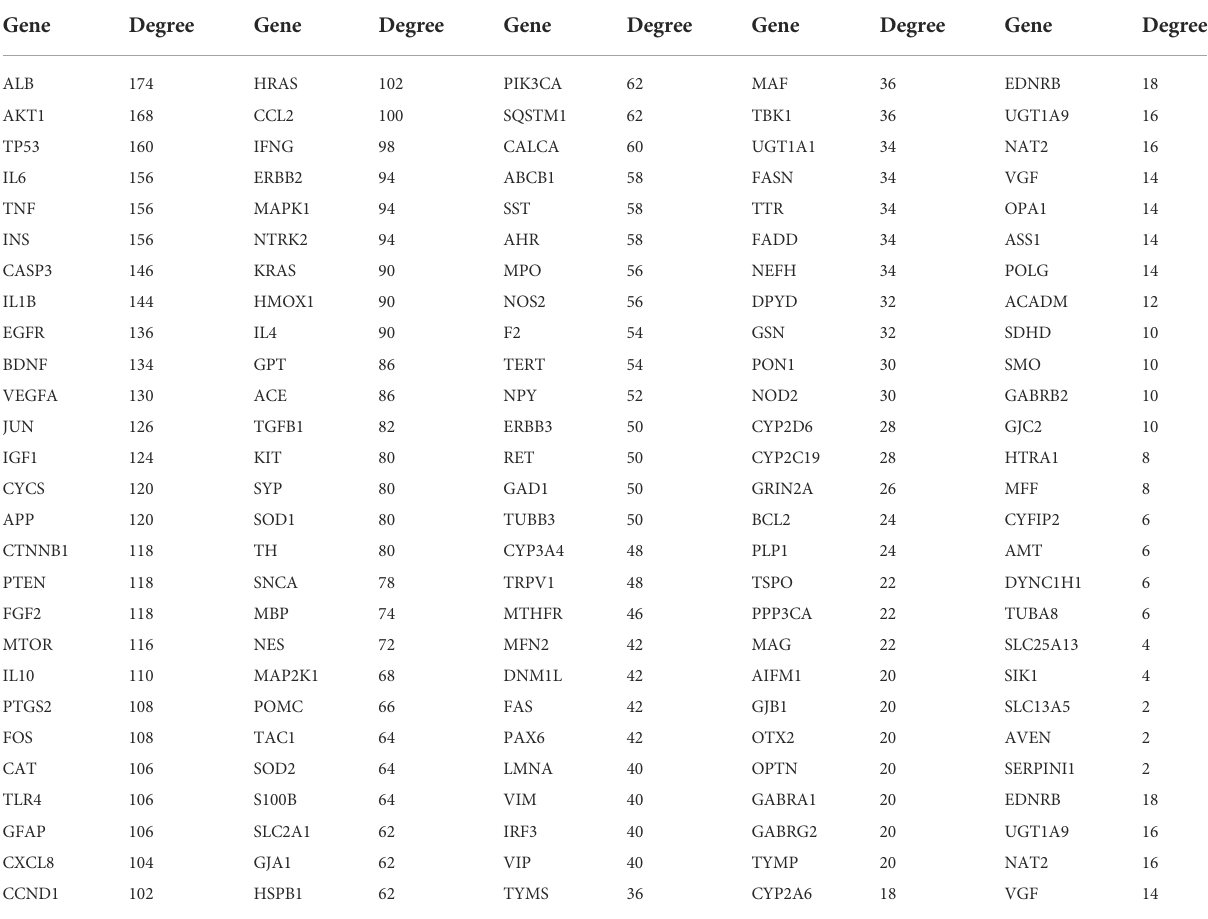
TABLE 2 Topological parameters of candidate